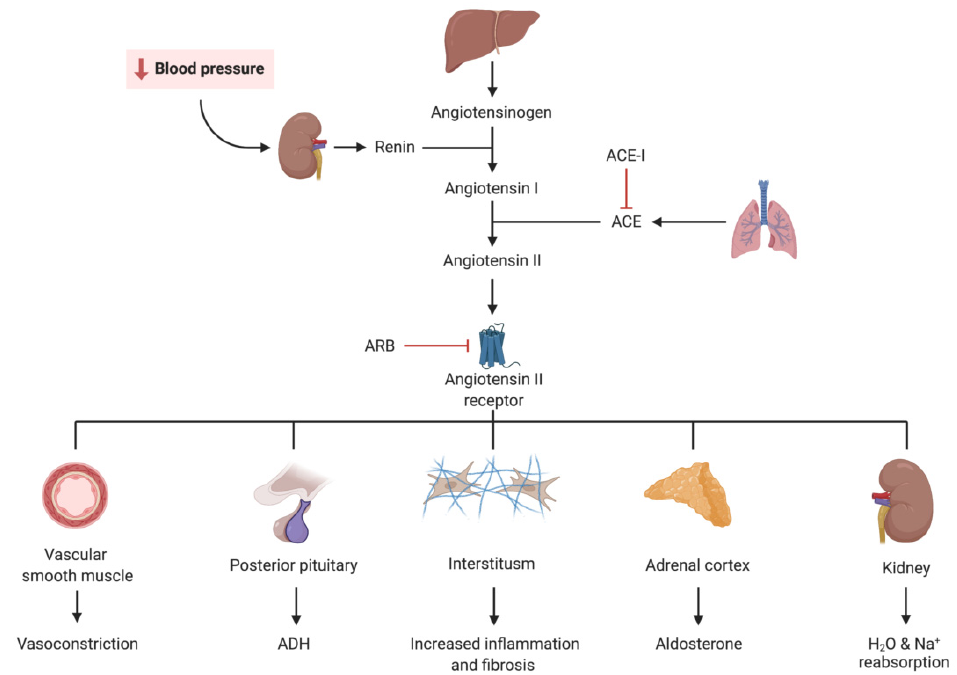
Figure 2. Visual representation of the renin–angiotensin–aldosterone system (RAAS) and the mech- anism of action of angiotensin-converting enzyme inhibitors (ACE-I) and angiotensin receptor blockers (ARB).